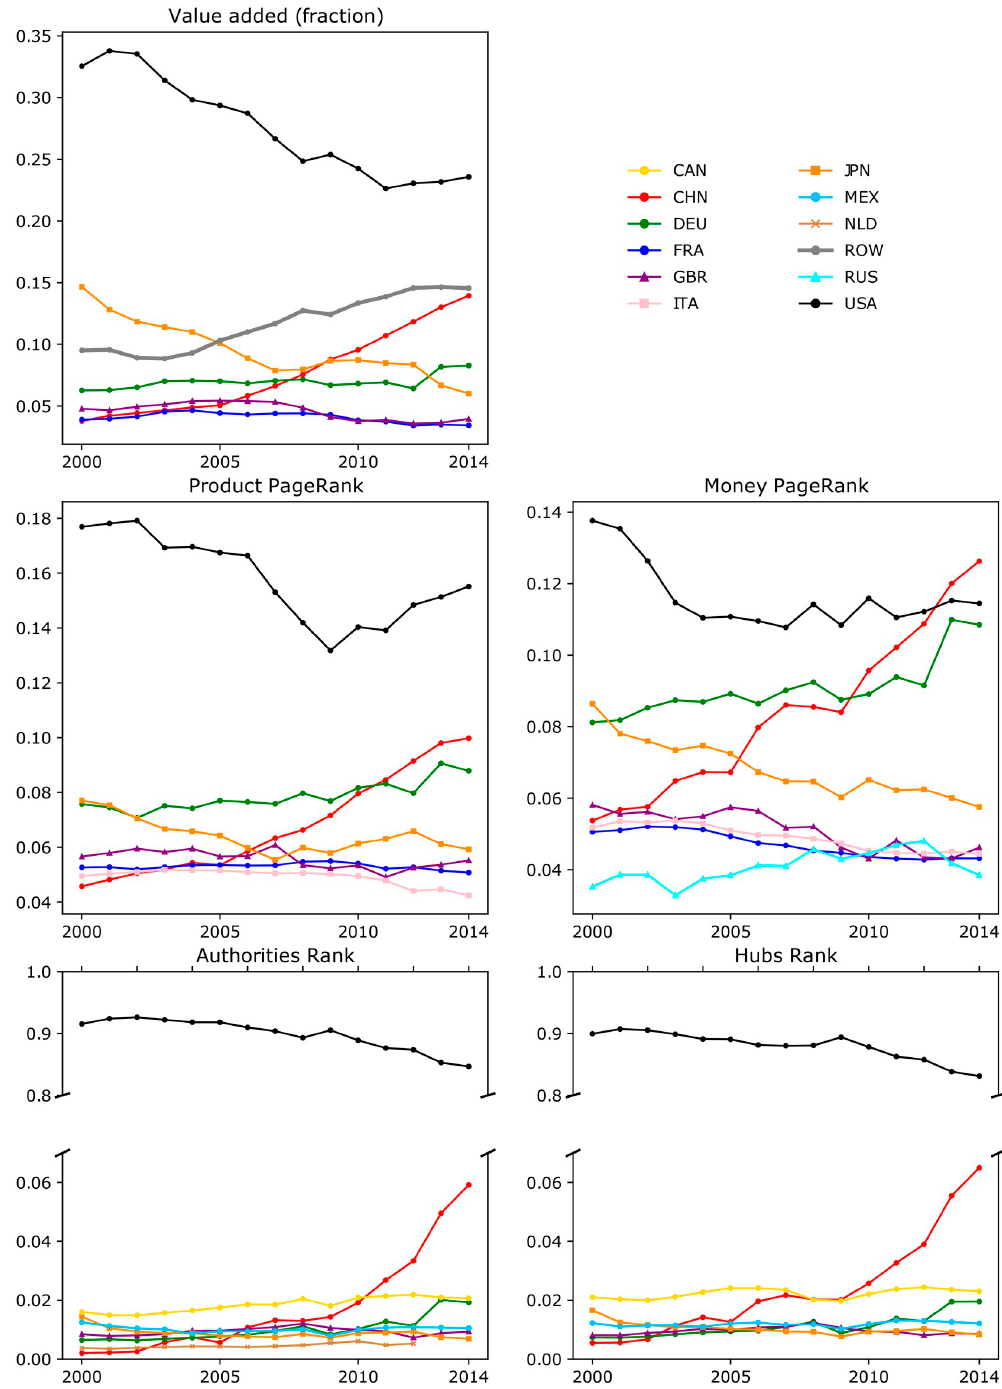
Fig 5. Ranking evolution of the top seven communities.